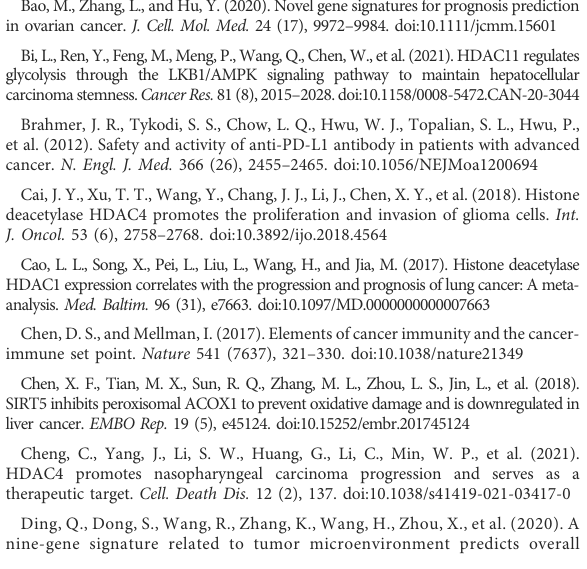
low-risk groups. SUPPLEMENTARY FIGURE S4 Kaplan – Meier survival curves of model